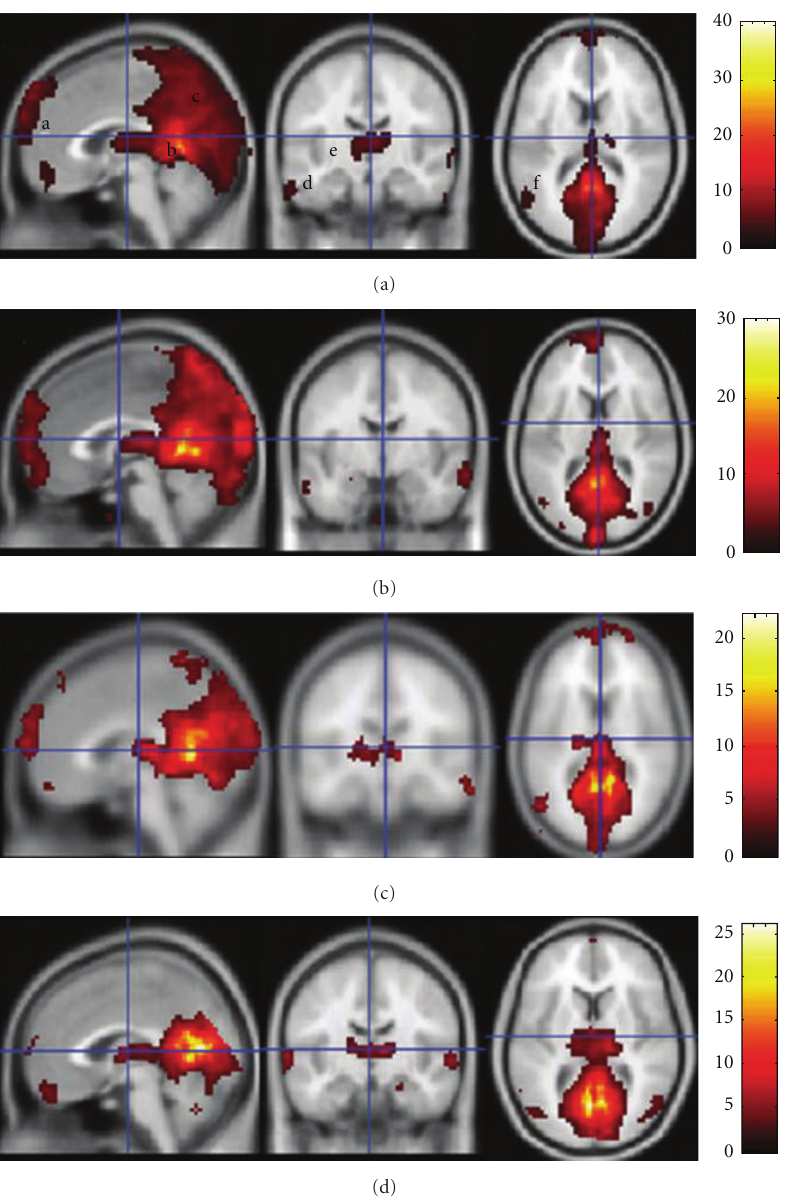
Figure 15: (a–d) Left to right: sagittal, coronal, and axial views of T1-weighted MNI canonical brain templates show intragroup maps of the default mode network (DMN) based on the seed of the PCC in, (a), control group, (b), mild AD group, (c), moderate AD group, and (d), severe AD group. The regions involved in the DMN are labeled as follows in (a): a = ventral MPFC, b = PCC, c = precuneus and/or cuneus, d = ITC, e = thalamus, and f = inferior parietal cortex. Color scale = t values (adapted with permission from